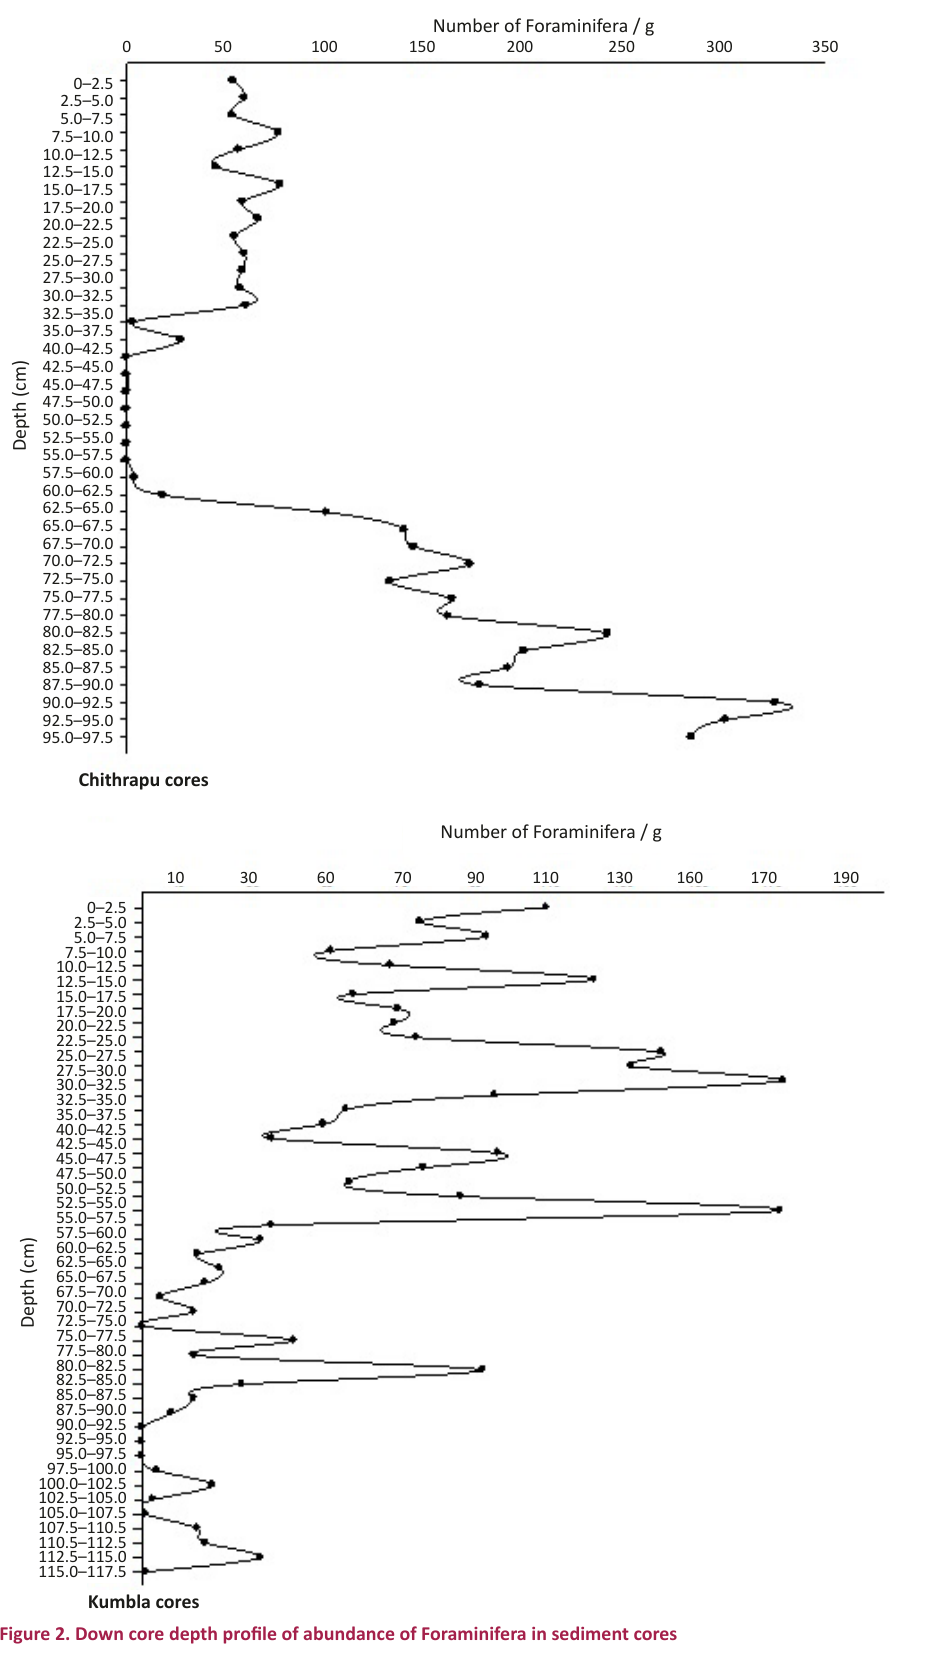
Figure 2. Down core depth profile of abundance of Foraminifera in sediment